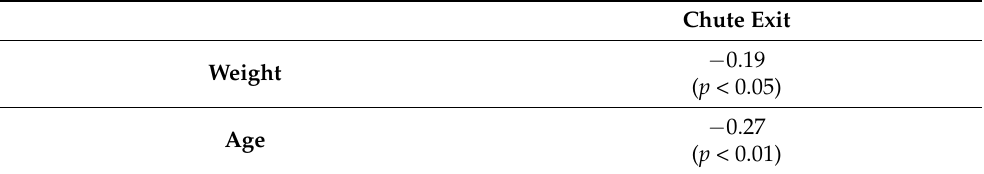
Table 5. Pearson correlation coe ffi cients for some of the parameters analyzed.